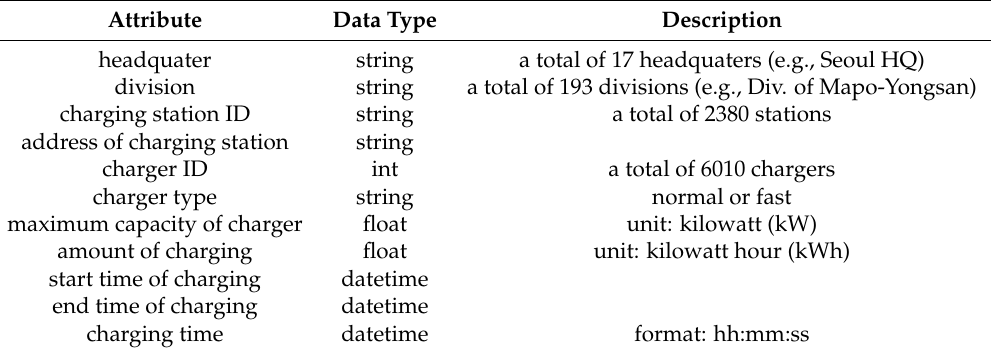
Table 1. Descriptions of the EV